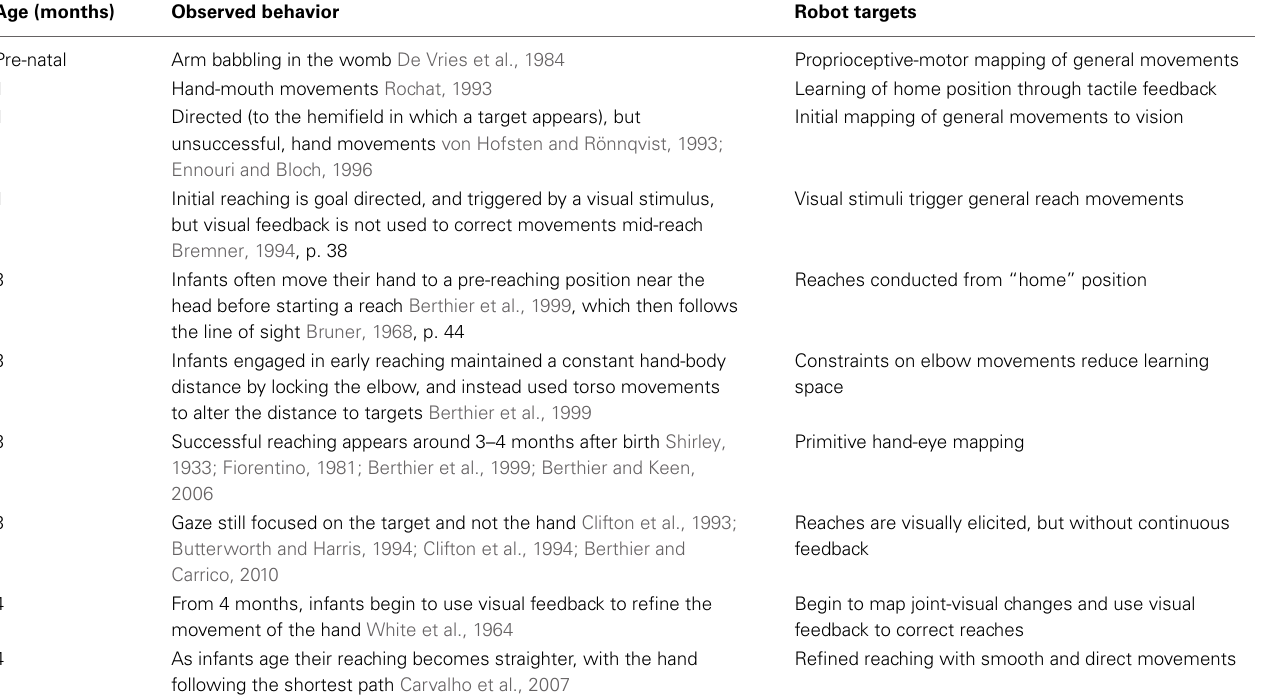
Table 2 | Reach development and learning